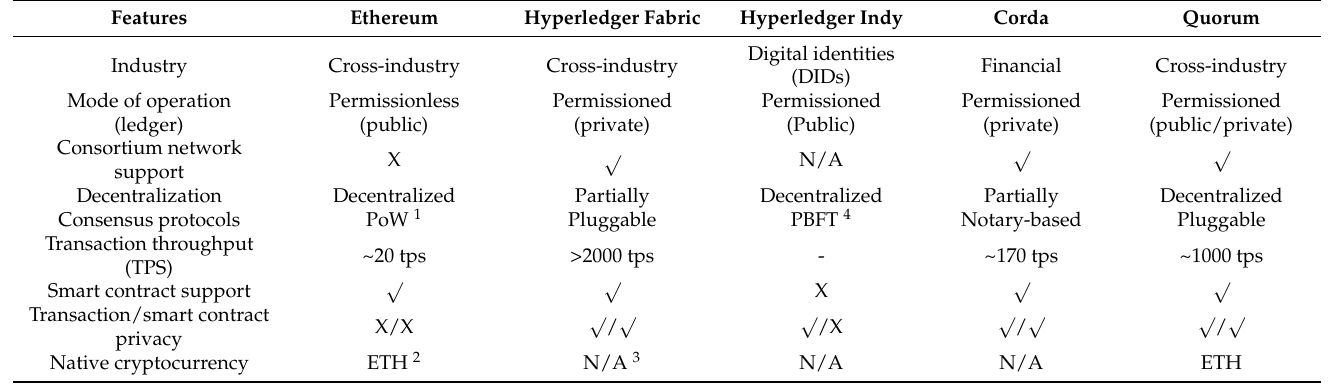
Table 1. Comparative evaluation of five major blockchain